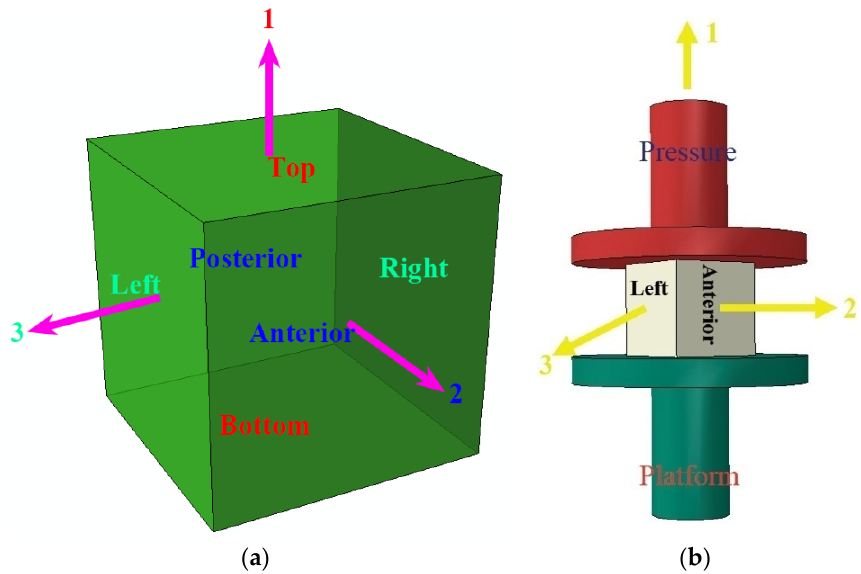
Figure 12. Strength and damage model in UCTs. ( a ) Coordinate system on the orthogonal damage tensor. ( b ) Cubic specimen position. 1 represented the first principal direction where the uniaxial compression load was applied and was formed by bottom and top faces of cubic specimen; 2 was the second principal direction and was formed by posterior and anterior faces; 3 designated the third principal direction and was formed by right and left faces.